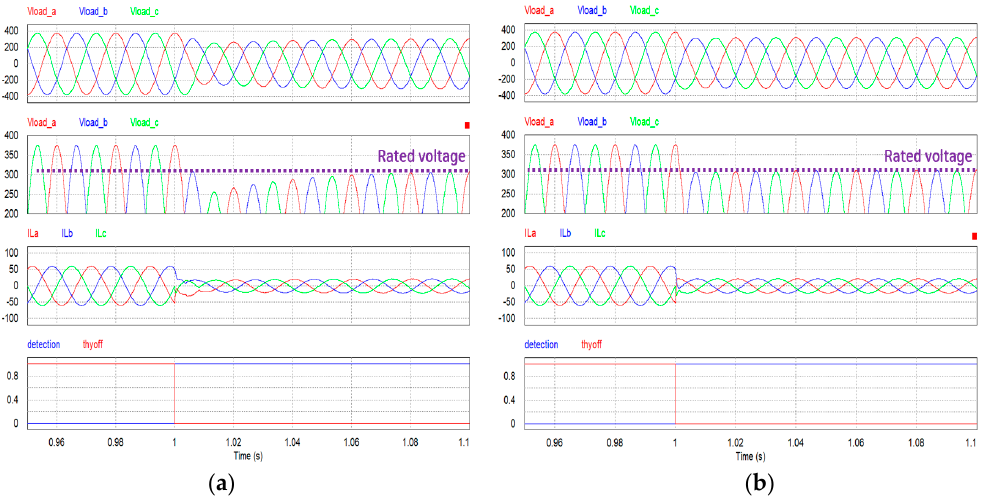
Figure 16. Simulation results of mode switching in the case of low grid voltage during battery charging: ( a ) using the general inverter controller; ( b ) using the proposed load current compensation controller.